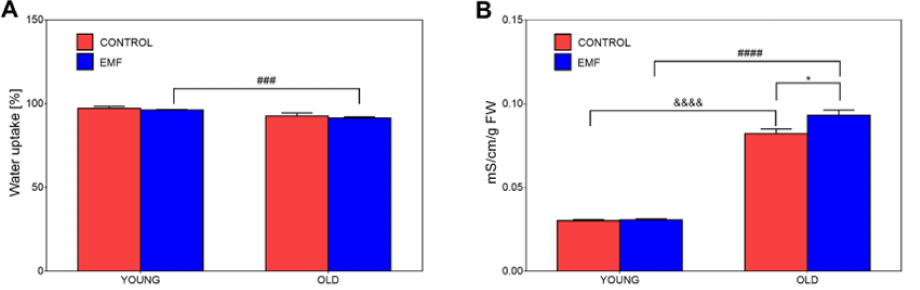
Figure 3. Changes in water uptake ( A ) and electrolyte leakage ( B ) in EMF-treated and untreated young and old seeds of field bean. Data are the means ± SE ( n = 4). The symbol (*) indicates significant differences between EMF-treated and control groups (* p < 0.05); “&” indicates significant differences between control groups ( &&&& p < 0.0001); “#” indicates significant differences between EMF-treated groups ( ### p < 0.001, #### p <